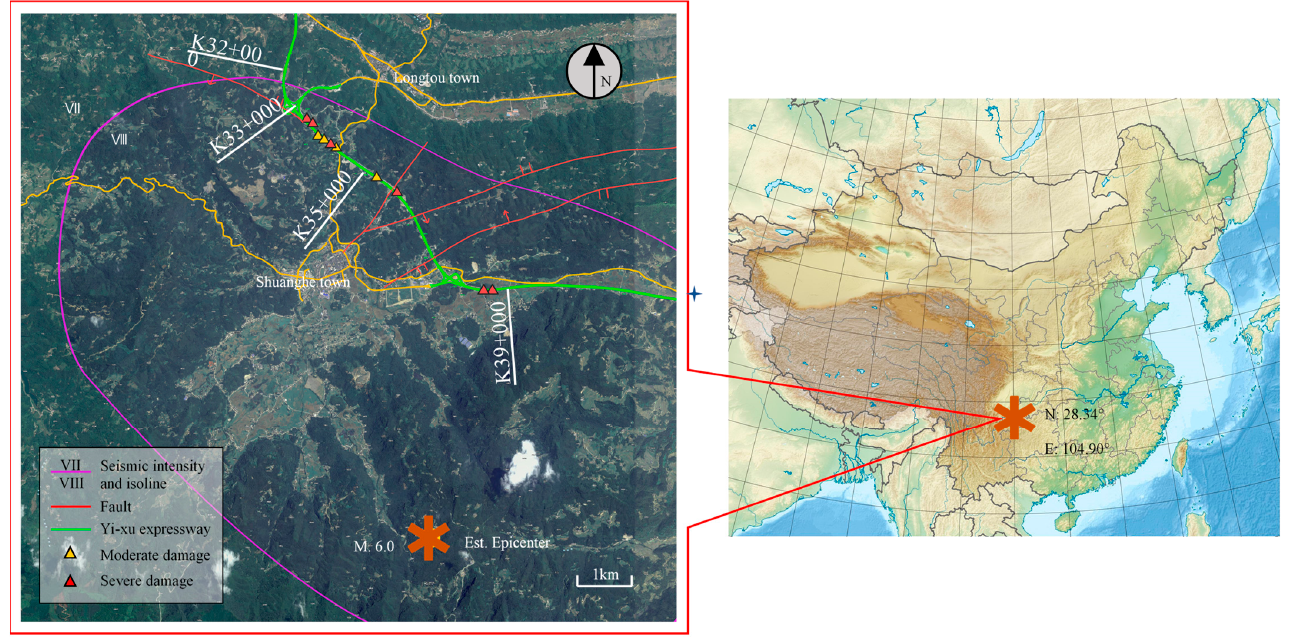
Figure 1. The damaged locations of the highway subgrades in the Changning earthquake event. At chainage K33 + 000–K39 + 000, the terrain along the route was undulating, and most of them were cut-and-fill subgrades (Figure 2a). The slope ratio of the fill portion